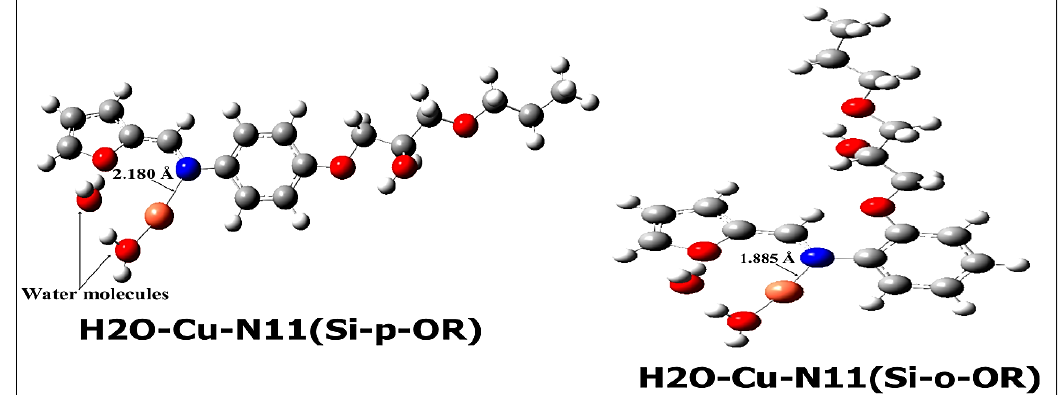
Figure 14. H 2 O-Cu-N11( Si-p-OR ) and H 2 O-Cu-N11( Si-o-OR ) complexes.